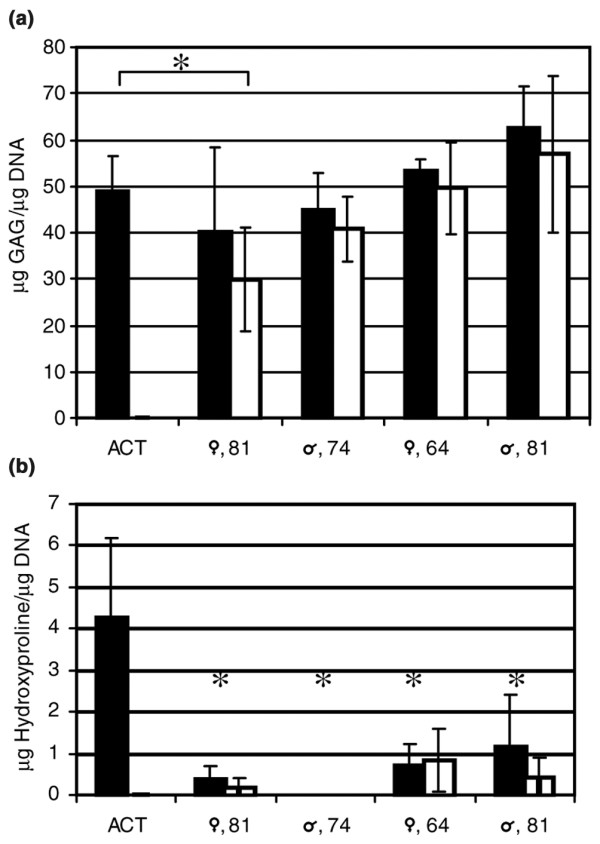
Biochemical analysis of pellets. Results are shown of the measurement of cartilage matrix protein accumulation in day 14 pellets normalized to cell number (DNA) in cells from the unaffected (filled bars) and affected (open bars) sides of four consecutive donors; the sex and age (in years) of the donors are indicated. Glycosaminoglycan (GAG) (a) and hydroxyproline (as a measure of total collagen content) (b) are shown as amounts per microgram of DNA. Results are means ± SD for three identical pellets. The amounts are compared with the mean value for four sequential autologous chondrocyte transplantation patients (ACT). An asterisk indicates a significant difference (P < 0.05) between ACT and osteoarthritis chondrocytes.